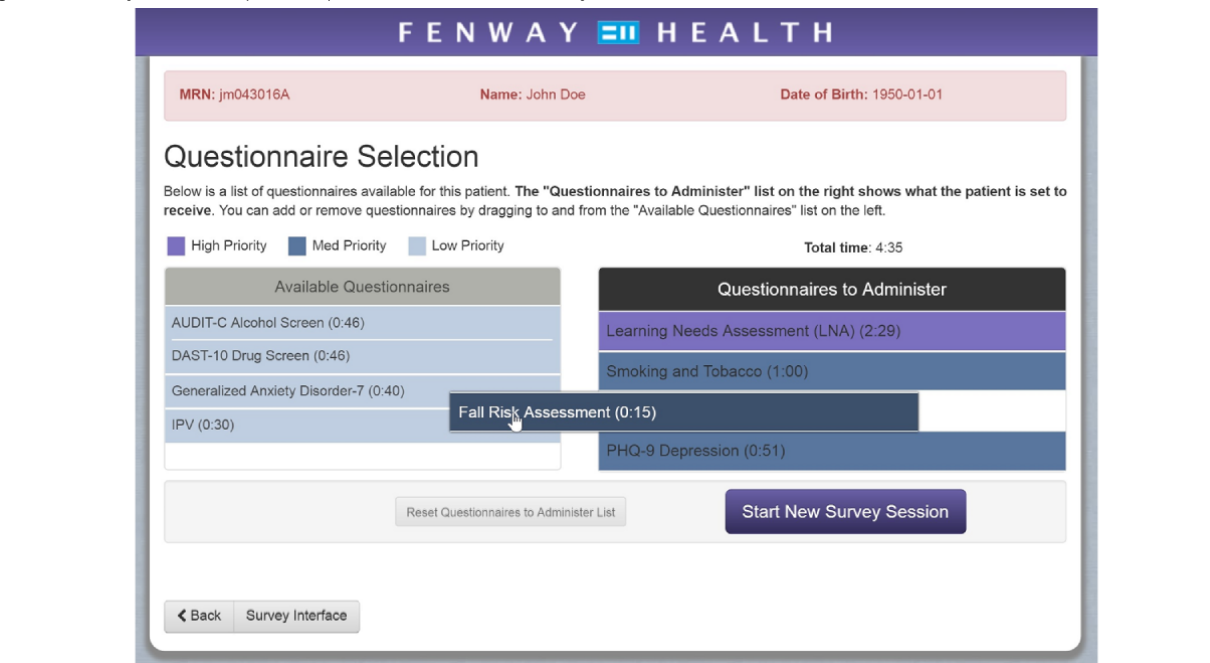
Figure 1. Fenway’s electronic patient-reported outcome (ePRO) survey